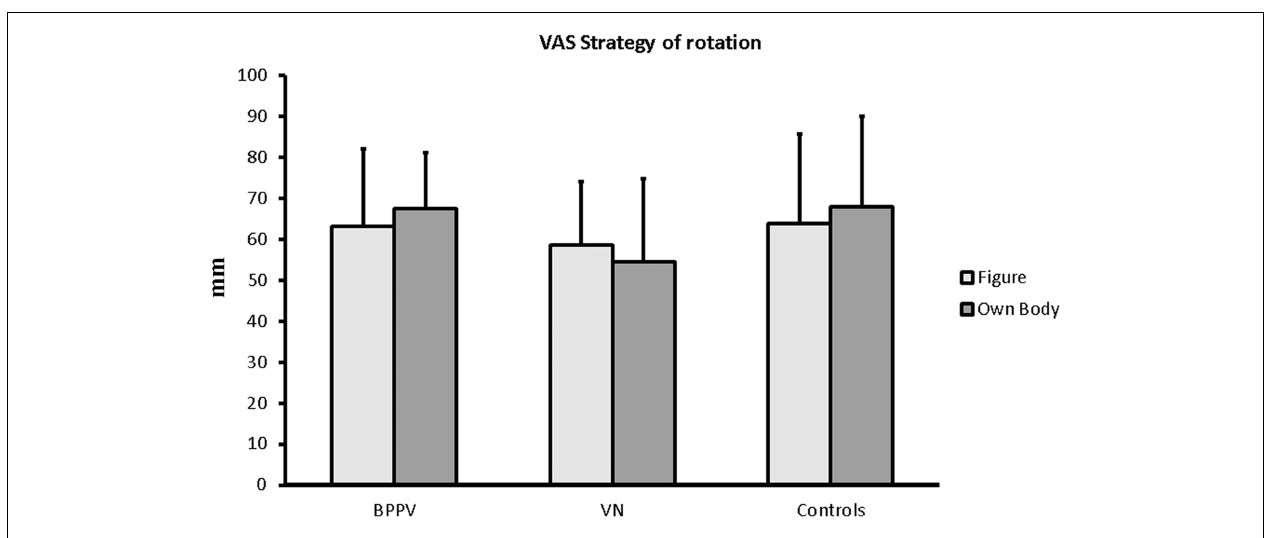
FIGURE 2 | GroupVAS ratings (mean ± standard deviation) for the subjective evaluation of the ability to follow the strategies in the two